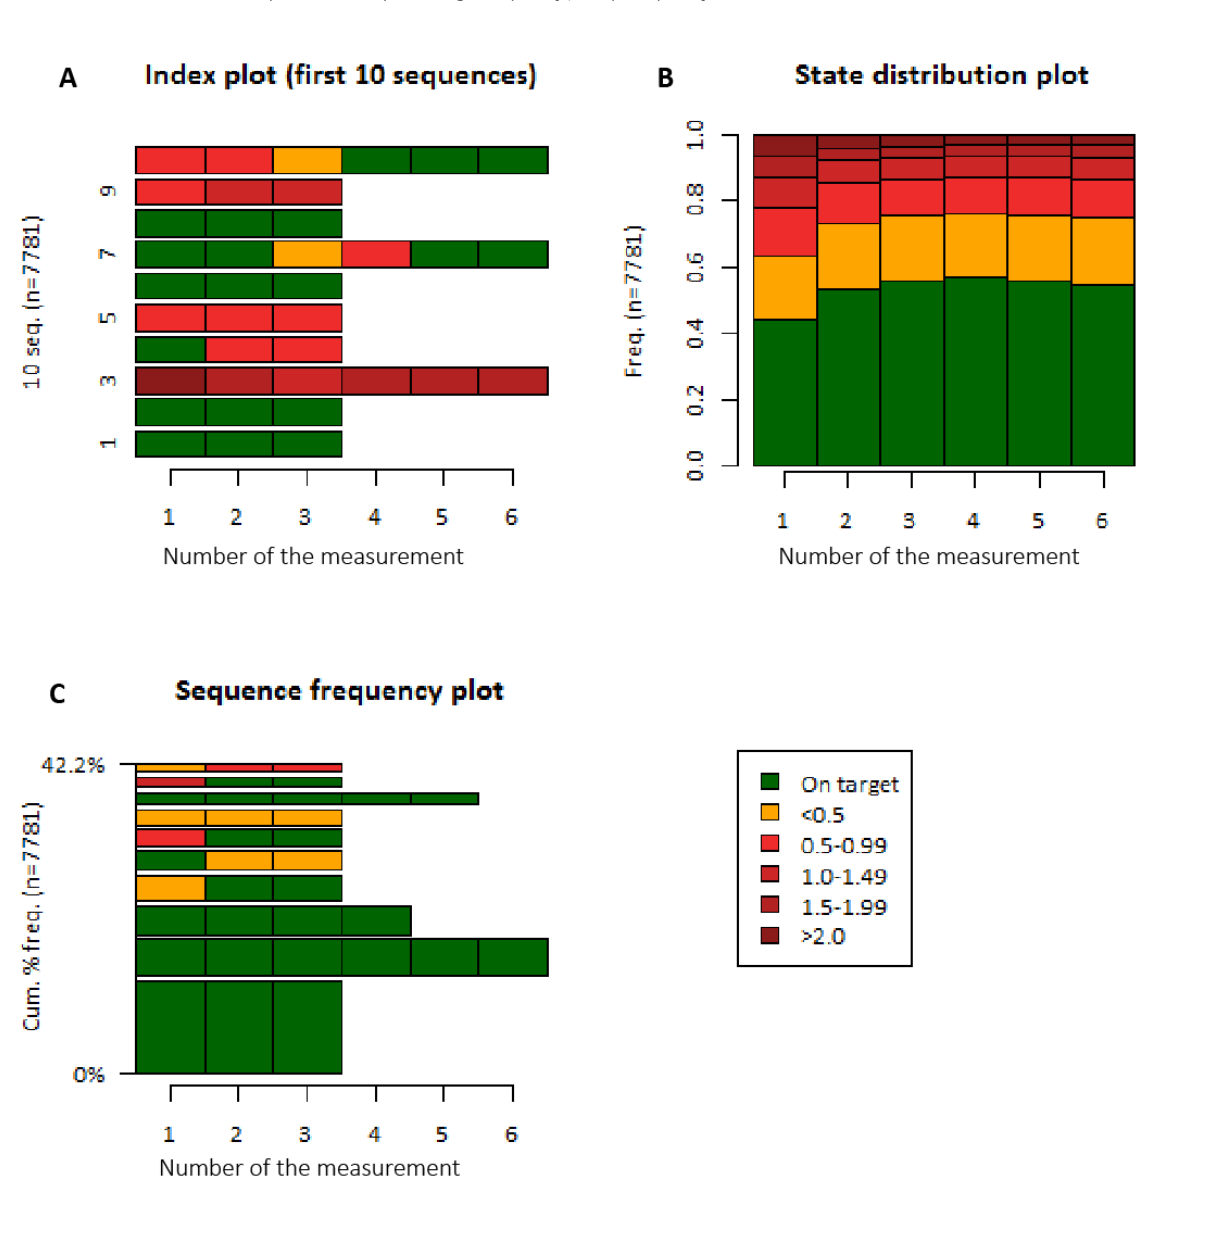
Figure 4. State sequences of low-density lipoprotein cholesterol (LDL-c) categories. A. Example of the sequences from the first 10 patients in the dataset (10 seq.). B. State distributions (equal to prevalence of LDL-c categories) per measurement. C. Most common sequences. LDL-c values in